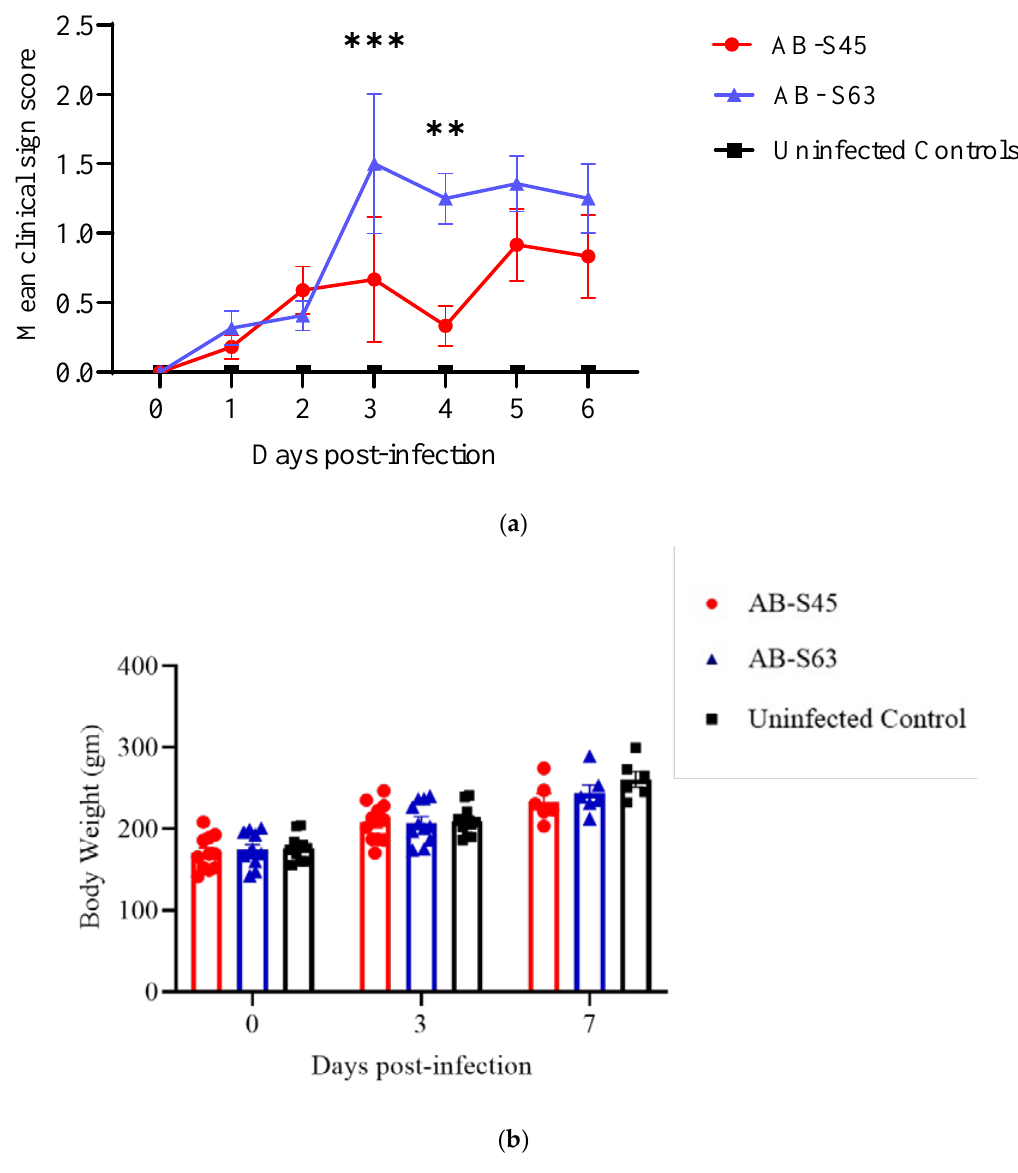
Figure 1. The clinical scores and body weights of chickens following infection with wildtype (AB-S63) and chicken-embryo-origin (CEO) vaccine revertant (AB-S45) ILTV isolates. The means of the clinical scores observed from 0–6 dpi and the body weights recorded on days 0, 3, and 7 following ILTV infection are plotted in ( a , b ), respectively. The error bars represent the standard error of means (SEM). The clinical signs were scored as described in the material and methods and statistically analyzed by employing the Kruskal–Wallis and Dunn’s multiple comparison tests. The differences in body weights between the groups were analyzed with the two-way ANOVA and Tukey’s multiple comparison tests. ** p < 0.01, *** p < 0.001 .